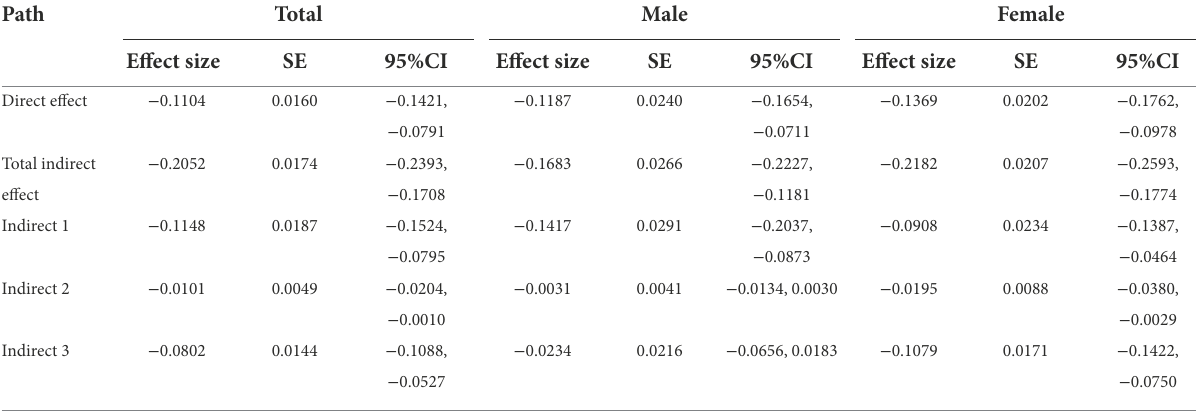
Table 4 The path and standardized indirect/direct effects of physical exercise on academic burnout in college students.